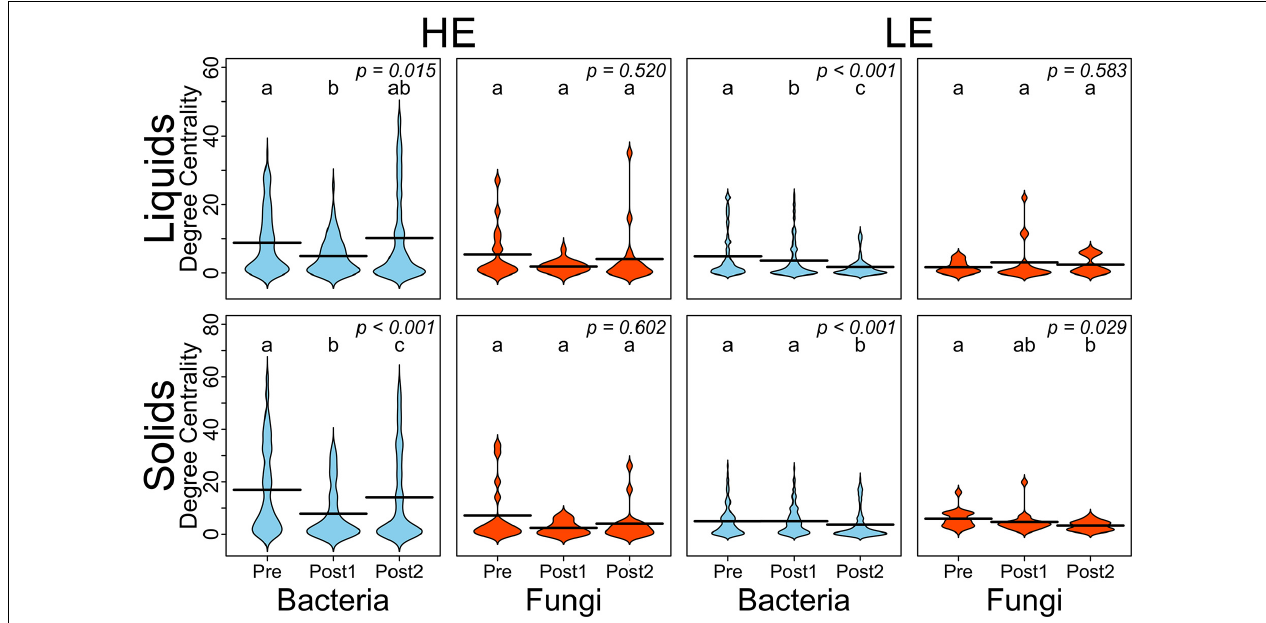
FIGURE 2 | Beanplots expressing average degree-centrality of nodes by domain and over time for HE and LE-derived rumen liquids and solids. Shared letters indicate no difference in degree between timepoints ( P > 0.05).